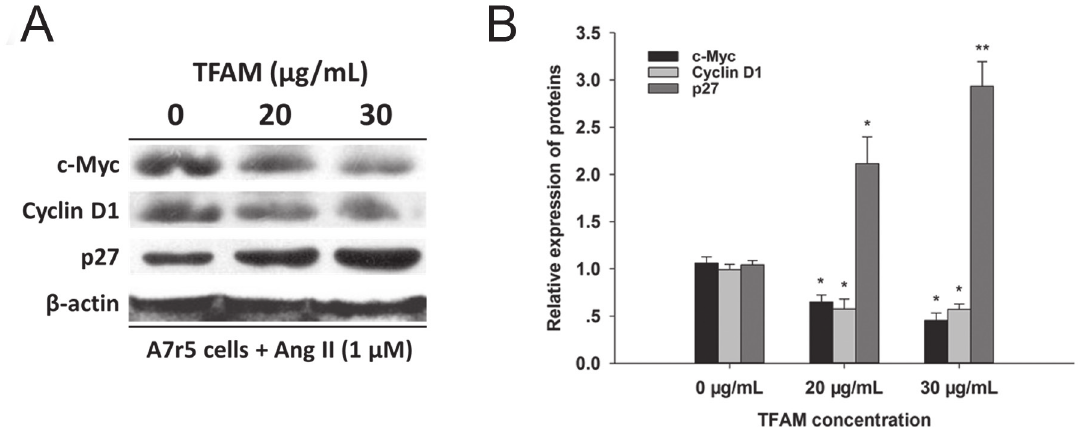
FIGURE 3 - TFAM suppressed protein expressions of c-Myc and Cyclin D1 and elevated the level of p27 Kip1 protein. (A) Protein expressions of c-Myc, Cyclin D1 and p27 Kip1 after 24 h of administration with 20 and 30 μg/mL of TFAM. (B) Bars represent the intensity of the bands of (A) quantitated by densitometry, respectively. No treatment control group was showed as 0 μg/mL of TFAM. Mean ±SD, n =3. * P <0.05 vs Ang II group; ** P <0.01 vs Ang II